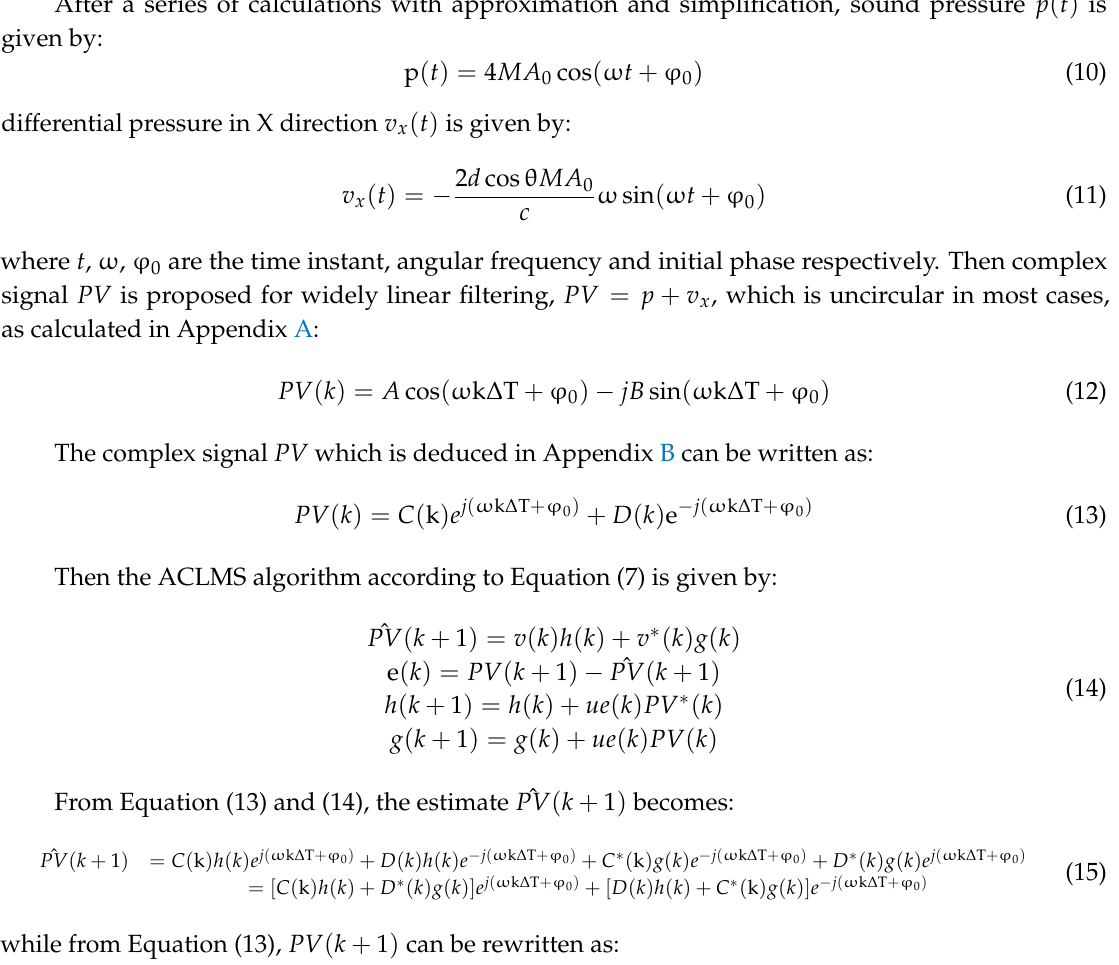
Figure 2. Schematic view of the structure of the pressure-gradient vector hydrophone.